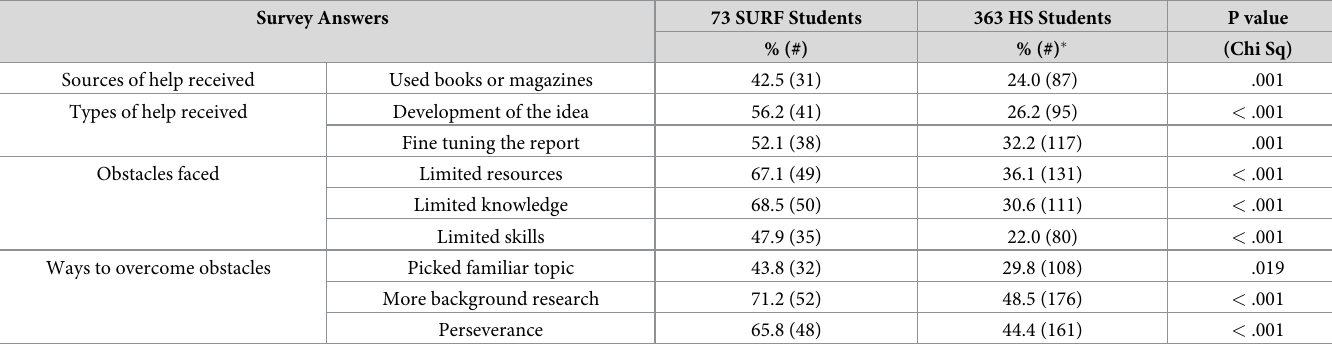
Table 3. Surf students vs. high school students—Differences in science fair experiences.